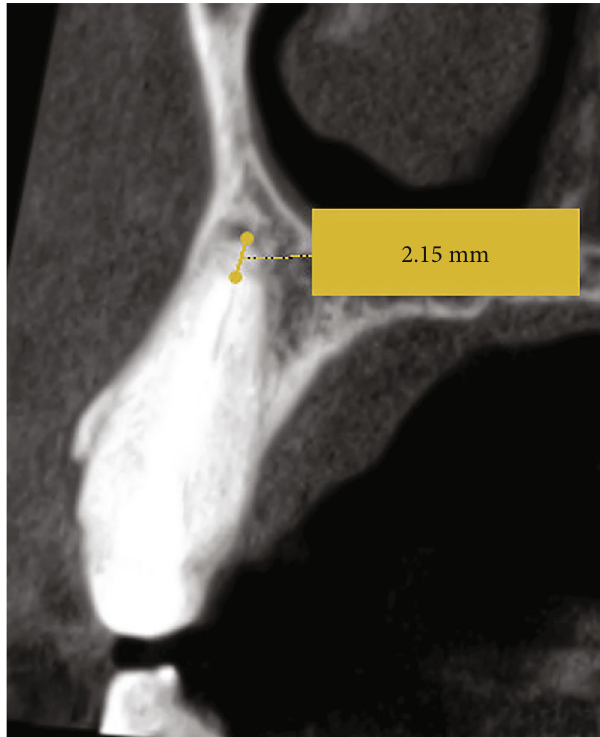
Figure 2: Preoperative CBCT assessment. Sagittal slice of tooth #23 con fi rms apical root resorption with the radiolucent area, 2.15mm short obturation, and fi ber post cemented up to the middle third.